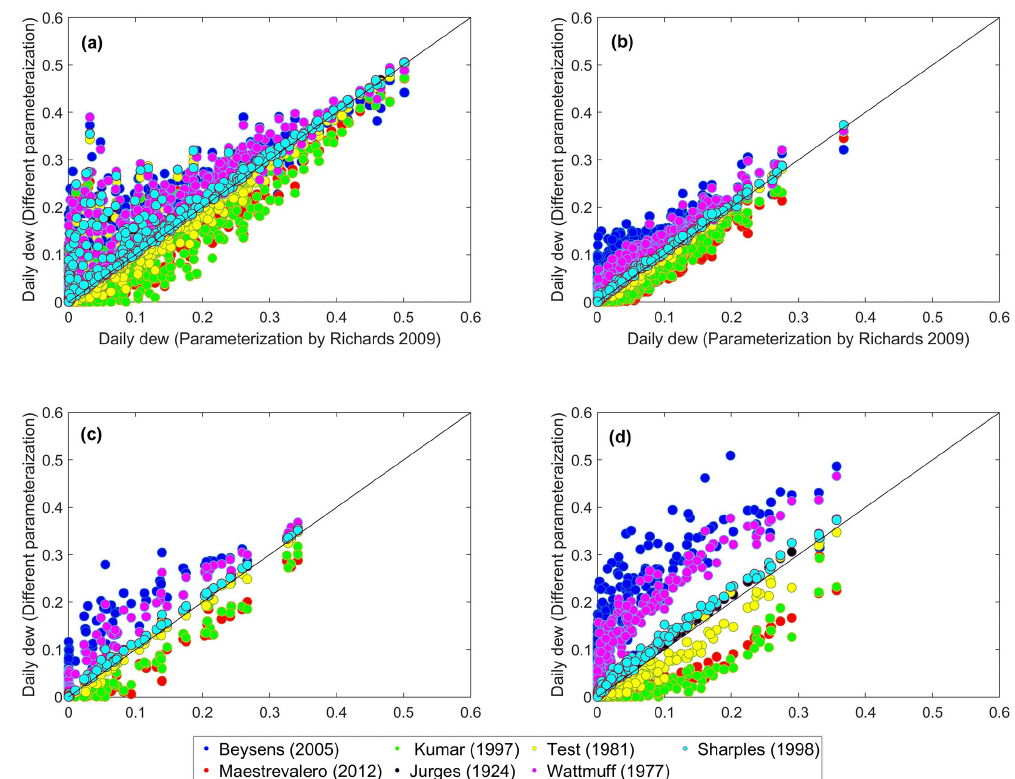
Figure 10. Scatter plots of the daily dew yield obtained from parameterization by Richards (2004) against seven different parameterizations listed in Table 6 for four stations in different areas of Iran. (a) Ramsar (forest and coastal area in the north), (b) Zanjan (mountainous area), (c) Tabas (desert area in central Iran), and (d) Bandar Abbas (arid coastal area in the south). The black lines are the 1 : 1